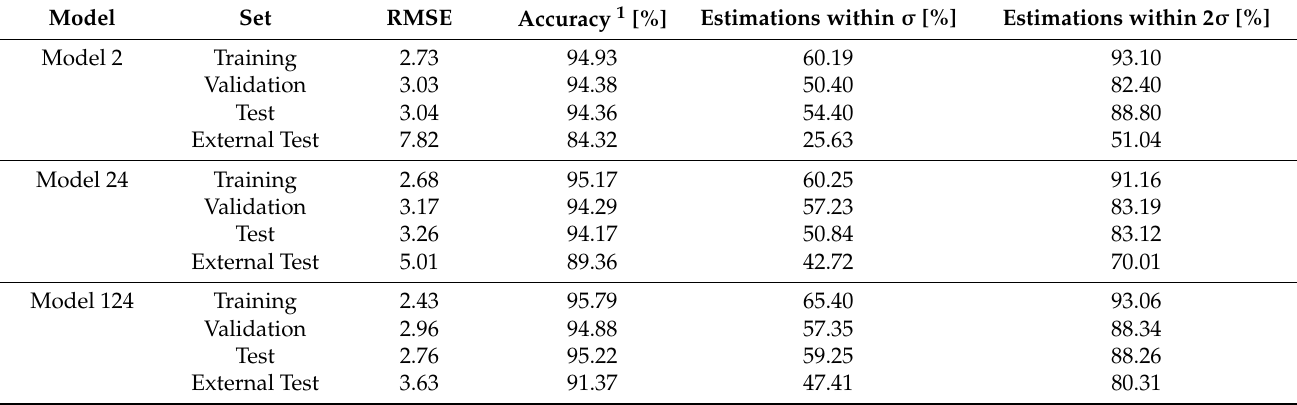
Table 5. Summary of the performance indicators for model 2, model 24 and model 124.